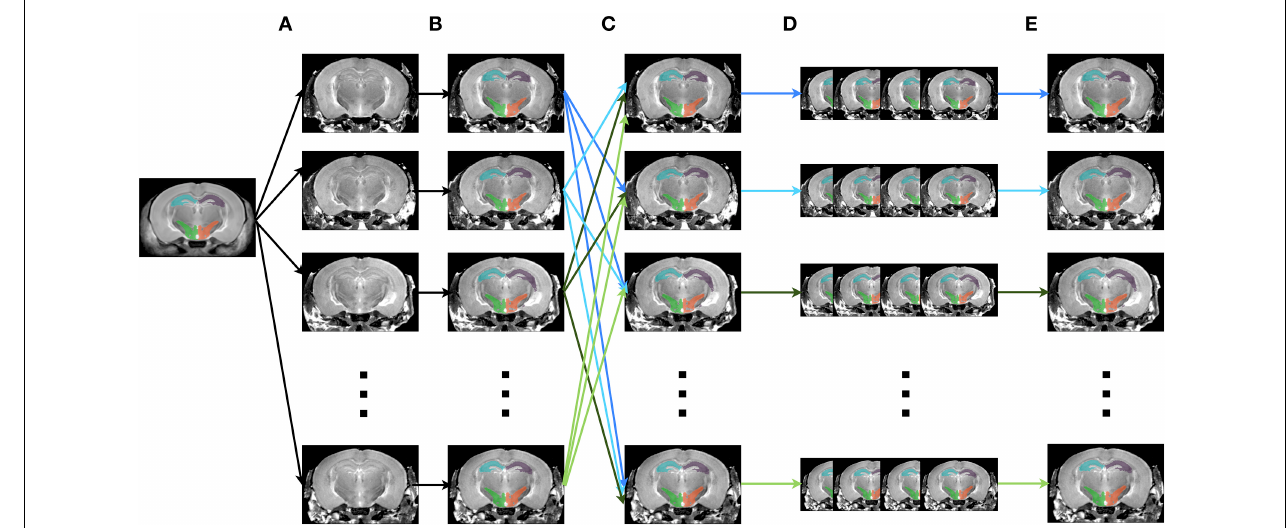
FIGURE 12 | Schematic of the MAGeT algorithm. (A) An initial labeled template is non-linearly aligned to a series of subjects. (B) Using the transform that results from step A, the labels from the template are propagated to each subject, creating a unique set of labels for that subject. (C) Each subject is non-linearly registered to